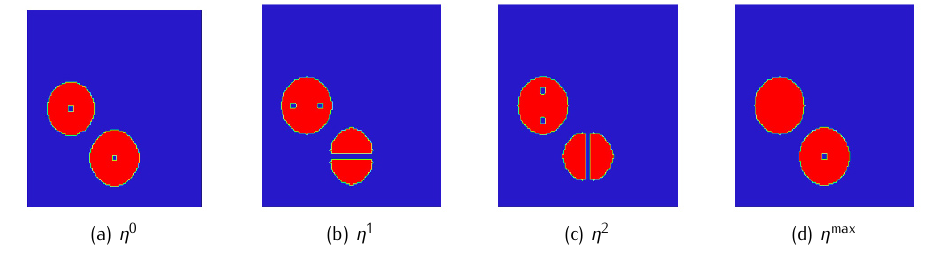
Figure 2. Solid body rotation: regularity of the initial